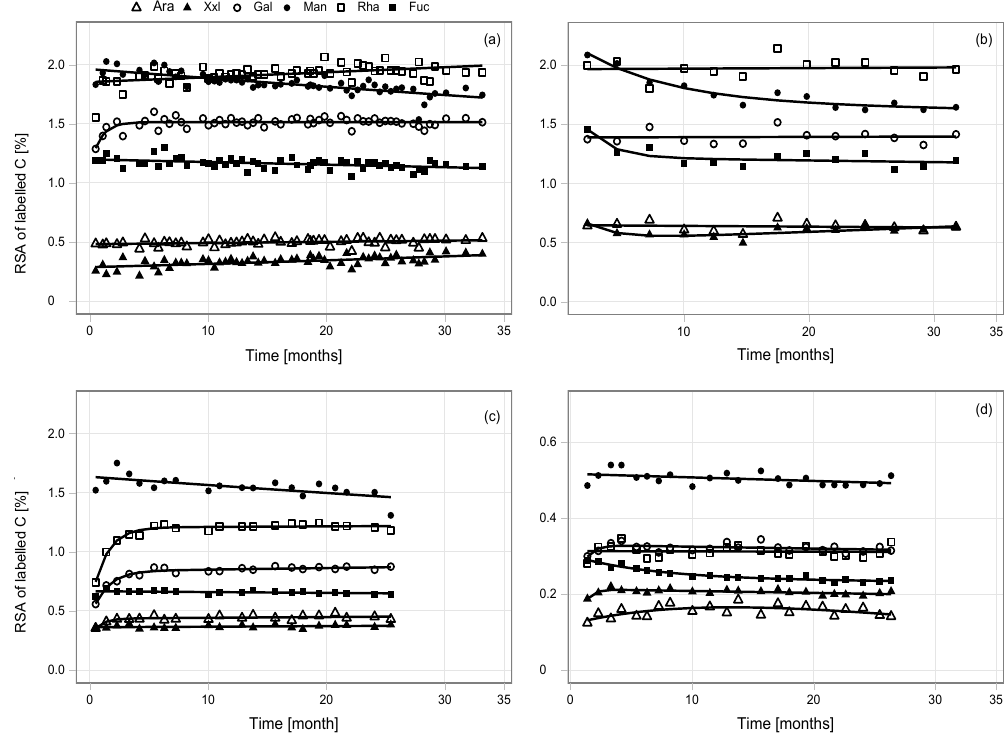
Figure 4. RSA of labelled C of individual sugars in the incubated soil samples. Lines show the fit of the observed data. a) wheat Ap, b) wheat E horizon of c) grassland and d) forest soil. The parameters of the exponential equations are given in Table